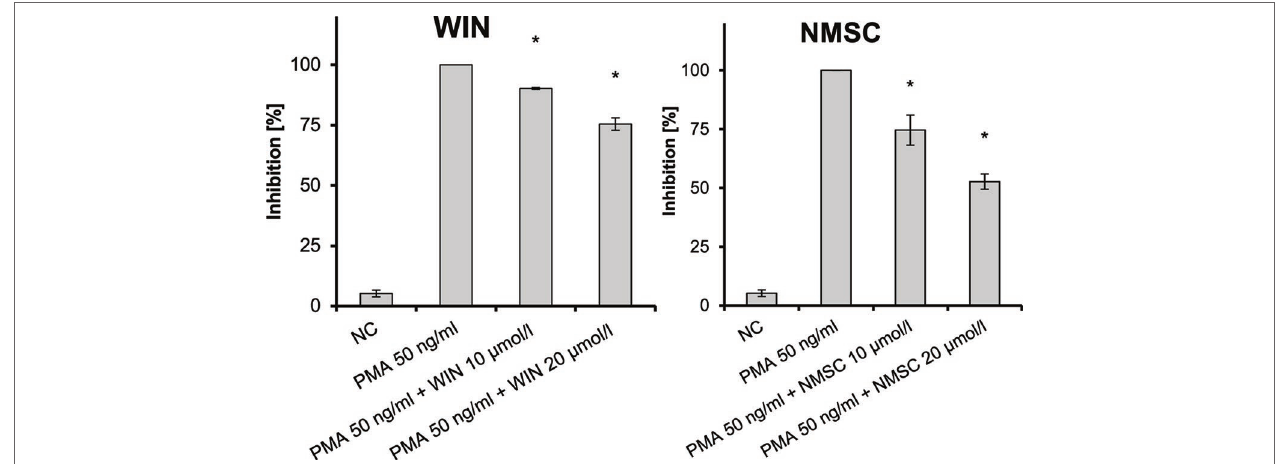
FigURE 8 | Effect of CHC (a) and HC (B) on the IL‑17‑stimulated mRNA expression of TNF‑ α , IL‑1 β , IL‑6, and CCL2 in RAW264.7 macrophages given as multiples of the reference gene expression. CCL2, CC‑chemokine ligand 2; CHC, cyclohexyl cannabidiolate; HC, n ‑hexyl‑cannabidiolate; IL, interleukin; mRNA, messenger RNA; NC, negative control; TNF, tumor necrosis factor; n = 3 independent experiments; error bars represent SEM, * p < 0.1.